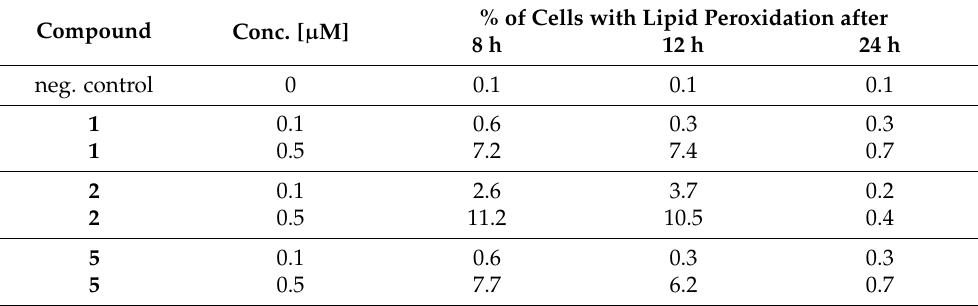
Table 2. Percentage of A2780cis cells with lipid peroxidation after treatment with complexes 1 , 2 , and 5 at the concentrations of 0.1 µ M and 0.5 µ M for 8 h, 12 h and 24 h. One representative experiment is depicted.